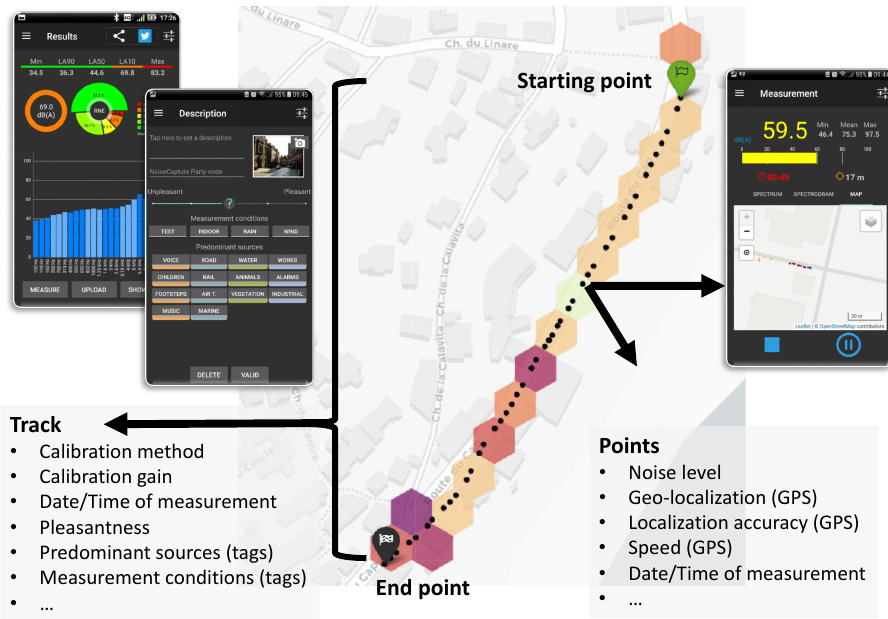
Figure 1. Representation of a NoiseCapture (NC) measurement. After manually activating the measurement from a starting point, the user can move along a path of their choice or stay at the same location. An acoustic measurement takes place every second, which allows us to calculate noise indicators, such as 1 s equivalent sound level and spectrum. Other information, such as the date and time of the measurements, the GPS location of the measurement point, its accuracy, and its speed are recorded at the same time. At the end of a track, the user stops the measurement and is invited to provide additional information about the presence of specific sound sources (tags) during the measurement, the measurement conditions, his own perception of the quality of the sound environment (i.e., the pleasantness), and other additional information. If the user has given his consent, the anonymous data are transferred to a remote server, controlled and then integrated into an open database, which is available for free. In addition, the raw data from the entire community are aggregated into a hexagonal based noise map and displayed on a public web page [10], as shown in this figure. Graphical contents of this figure are part of the Noise-Planet project website [11], licensed under CC BY-NC-SA